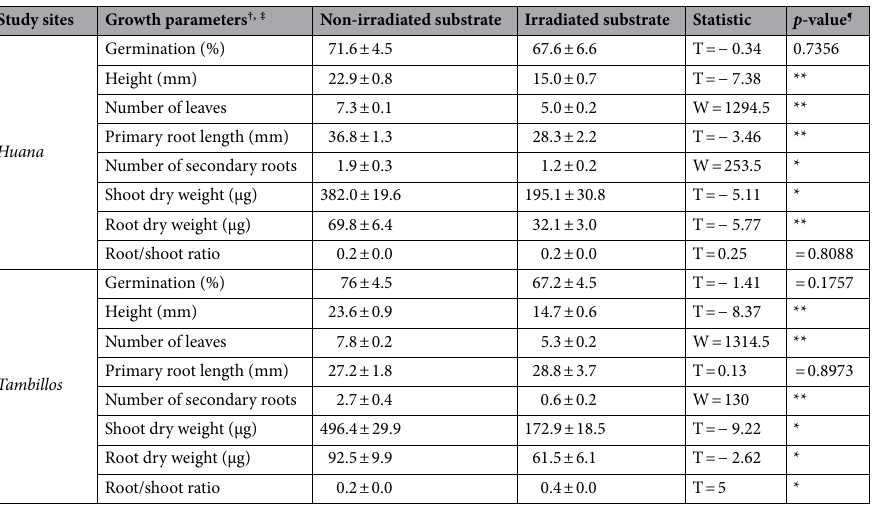
Table 3. Germination rate and plant-growth parameters in Baccharis linearis plants sown and grown in non- irradiated or irradiated tailing substrates from Huana and Tambillos. † Plant-growth parameters were measured seven weeks after sowing. ‡ Values represent averages ± SE of 50 replicates per treatment. ¶ Significant differences considering irradiation as factor, T-Student test (T) or Wilcoxon (W). *p < 0.05. **p <